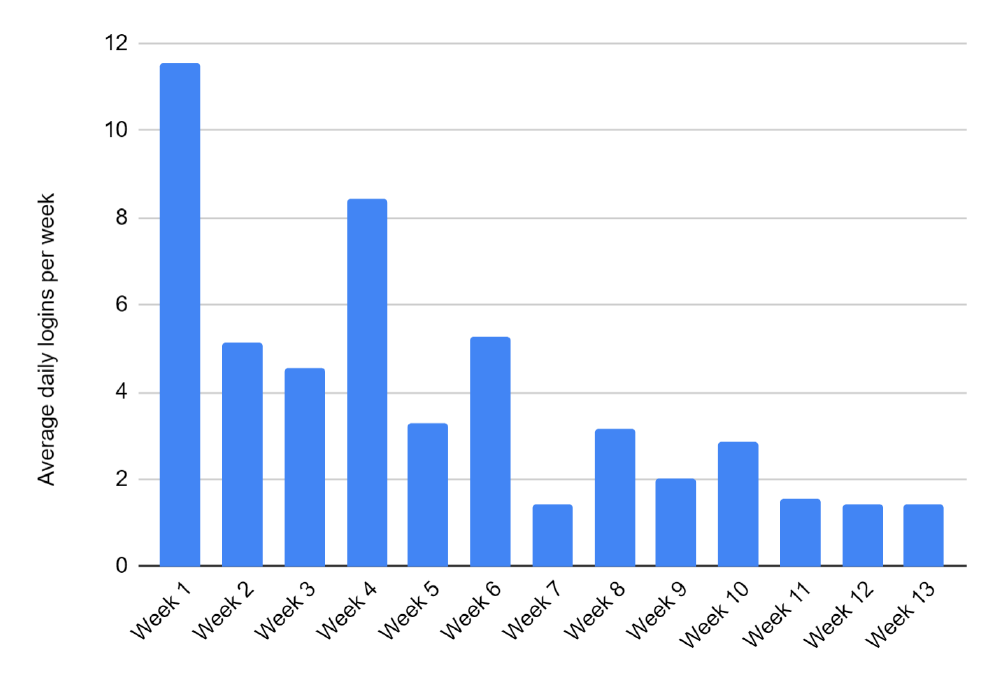
Figure 6. Number of logins, per